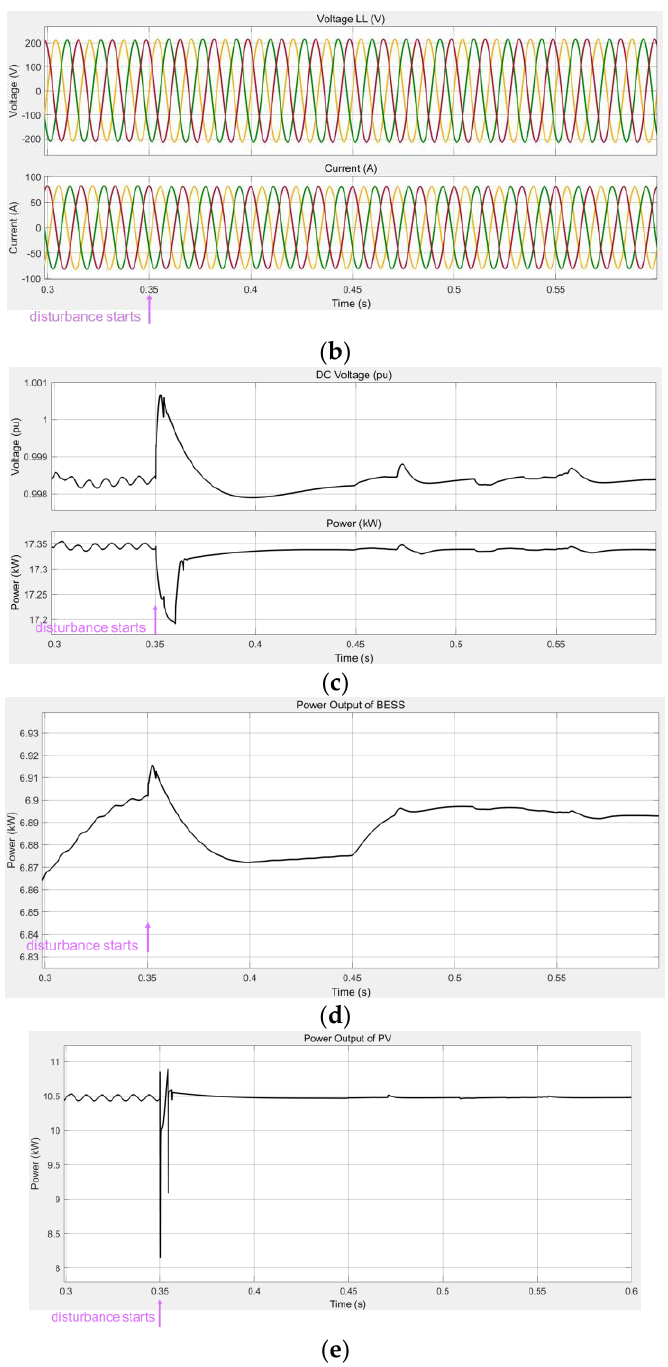
Figure 15. Performance when an AC-side load shedding happens. ( a ) Signals at Bus 6; ( b ) Signals at AC/DC interfacing Bus 8; ( c ) Signals at DC bus; ( d ) Power output of the BESS; ( e ) Power output of the PV generation.